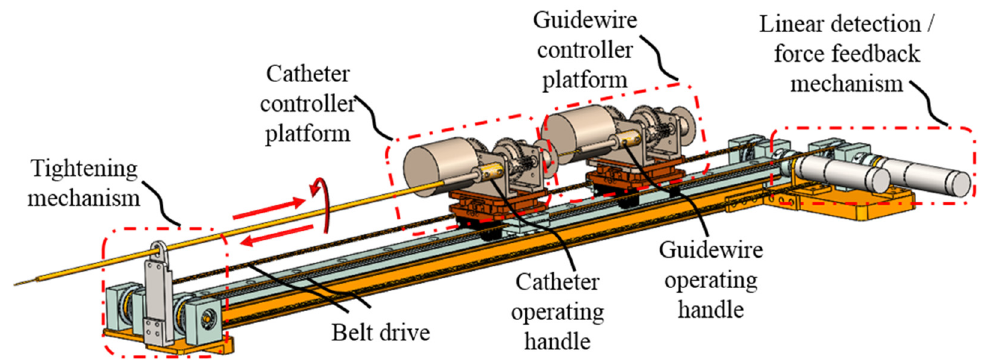
Figure 3. Schematic of the master side controller structure. The operator needs to hold the operating handle of the catheter and the guidewire with each hand during an operation. The linear detec- tion/force feedback mechanism behind the controller consists of two motors. The encoder of each motor is used in providing feedback to the linear detection of each controller platform, and the torque of the motor is used to generate force feedback for the operator.